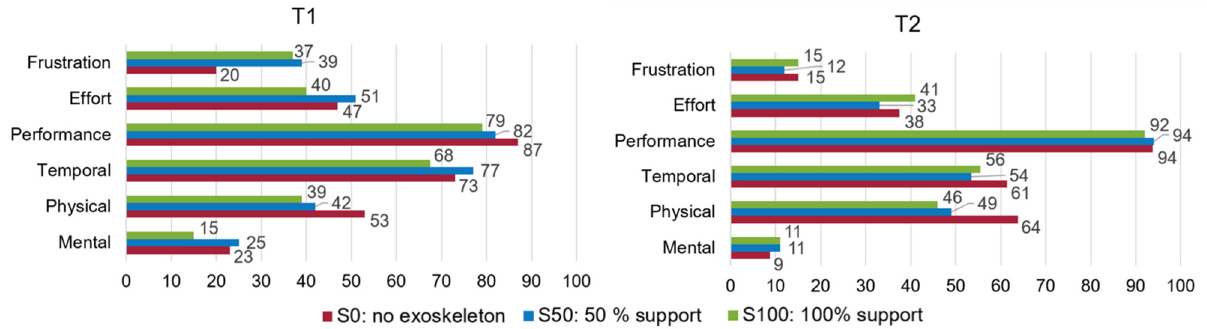
Figure 8. Mean values of NASA TLX of all participants for task T1 ( left ) and task T2 ( right ). The physical load on the user was reduced with an increasing support level of the exoskeleton.